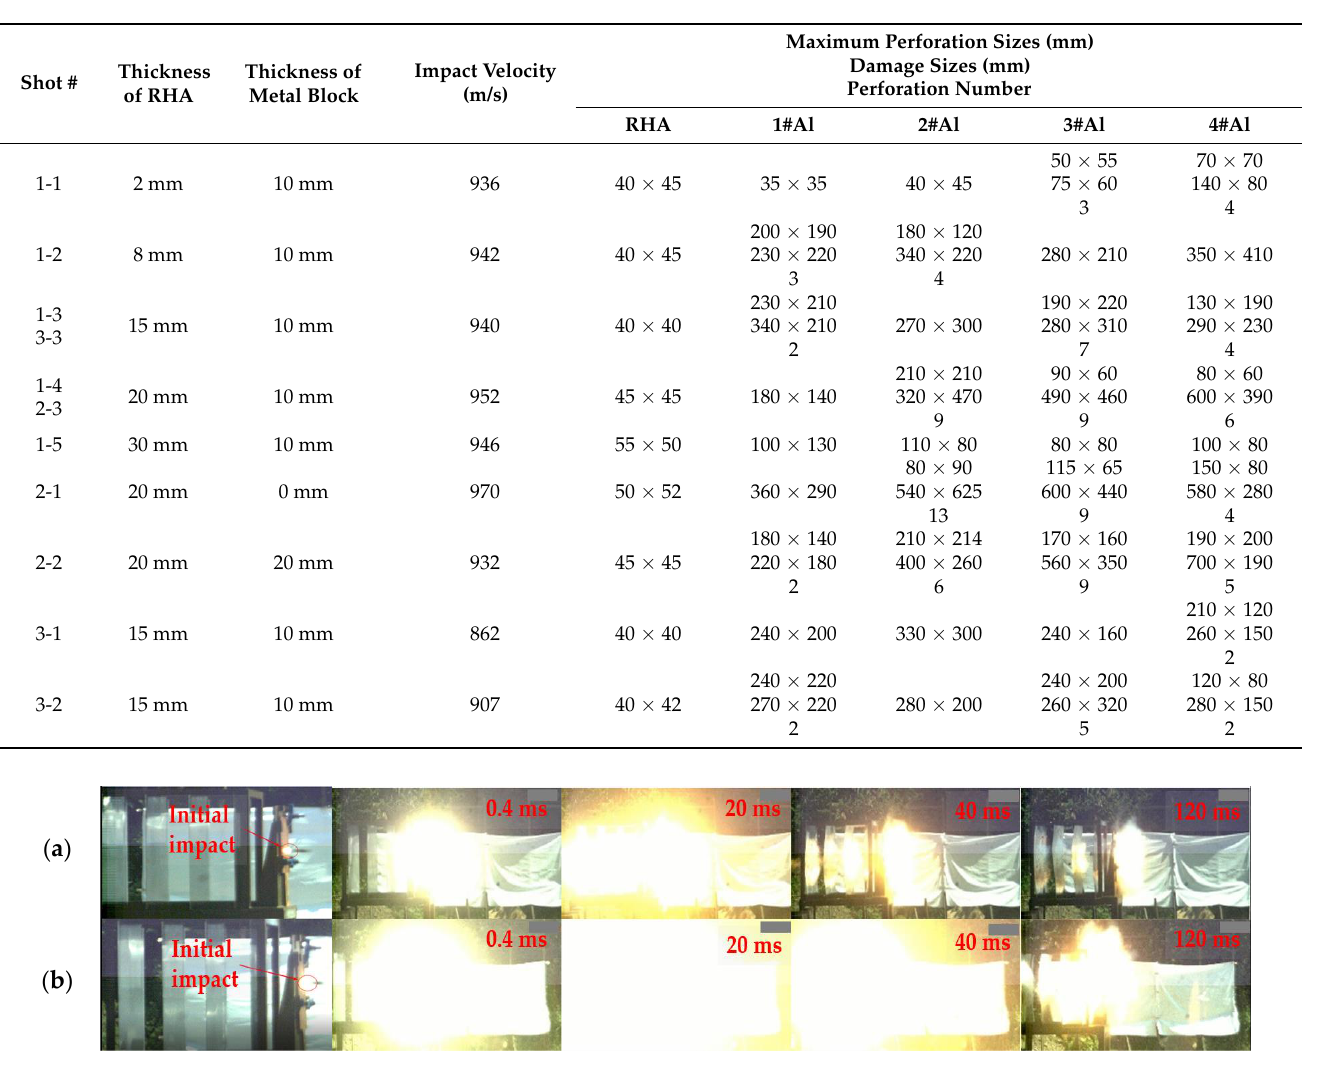
Table 3. Experimental results.